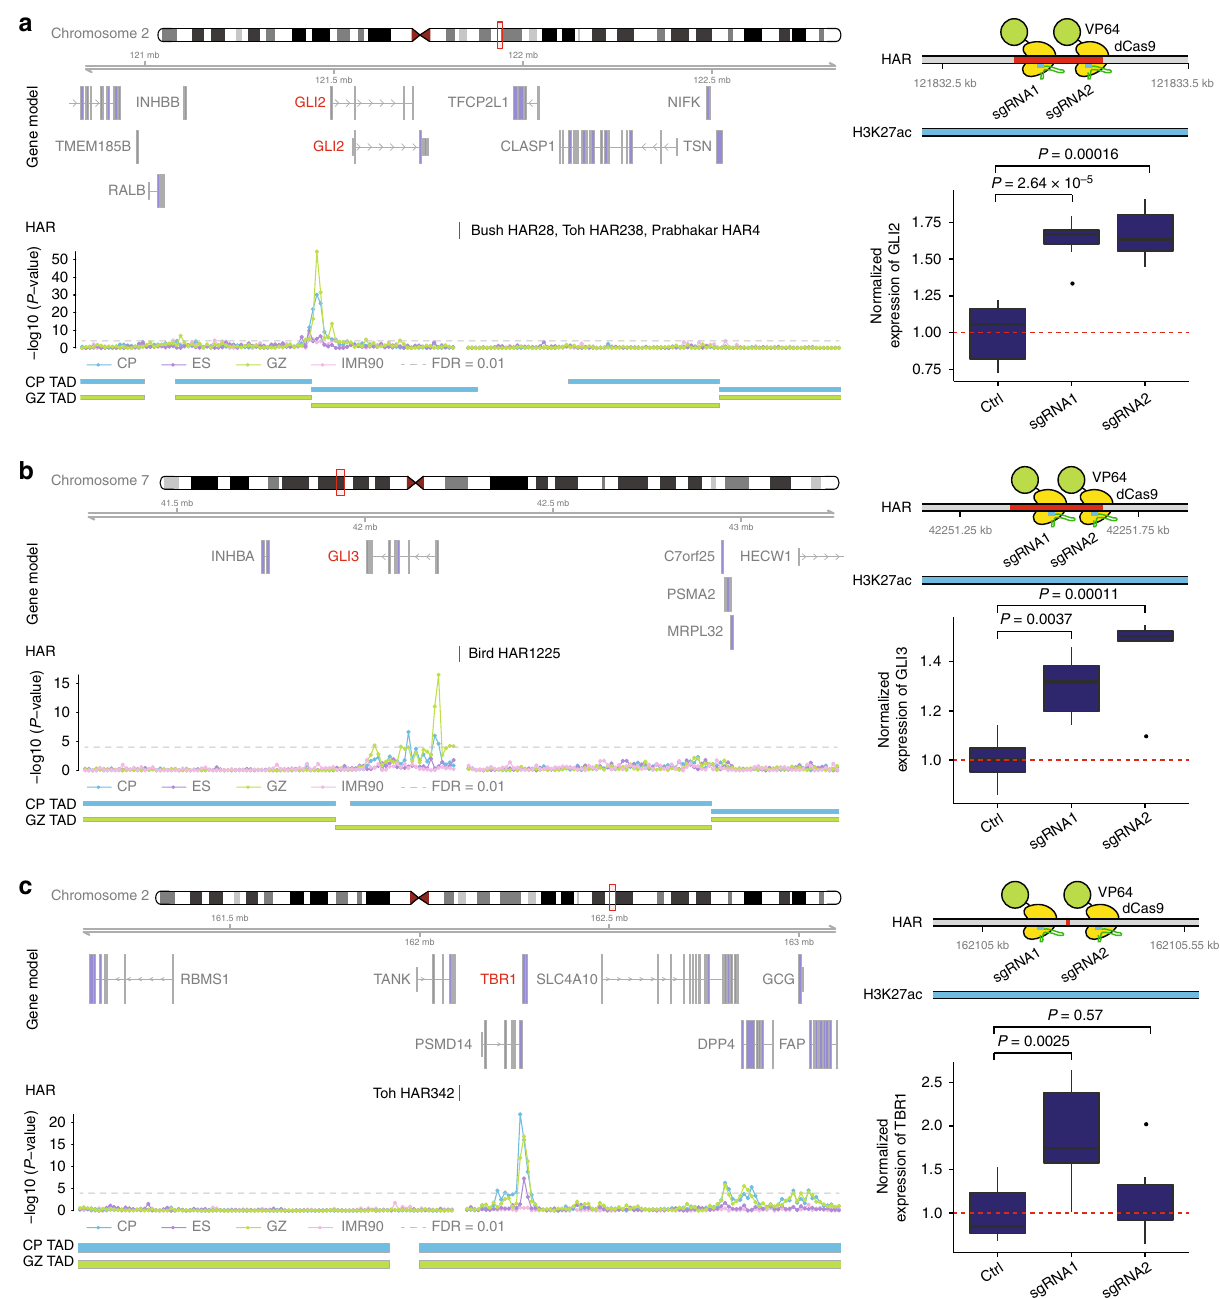
Fig. 4 Functional validation of HAR-interacting genes. a – c Left, chromatin interaction map of HARs that interact with GLI2 ( a ), GLI3 ( b ), and TBR1 ( c ). Gene Model is based on Gencode v19 and possible target genes are marked in red; Genomic coordinate for HARs is labeled as HAR; − log10 ( P -value), signi fi cance of the interaction between HARs and each 10 kb bin, gray dotted line for FDR = 0.01; TAD borders in CP and GZ are shown. Right, targeted binding sites for two guide RNAs (gRNAs). The HAR is located in the active enhancer marks (H3K27ac) in fetal brain. Targeting dCas9-VP64 to HARs in primary human neural progenitor cells (phNPCs) results in an 30 – 80% increase in the expression level of putative target genes predicted by Hi-C. Normalized expression levels of putative target genes ( GLI2 ( a ), GLI3 ( b ), and TBR1 ( c )) relative to control (Ctrl). n = 6 (Ctrl), 8 (gRNA1), 6 (gRNA2) for GLI2 ; 7 (Ctrl), 6 (gRNA1 and gRNA2) for GLI3 ; 5 (Ctrl), 6 (gRNA1 and gRNA2) for TBR1 . P -values, one-way ANOVA and post hoc Tukey test. Center, median; box = 1st – 3rd quartiles (Q); lower whisker, Q1 − 1.5×interquartile range (IQR); upper whisker, Q3 + 1.5 ×